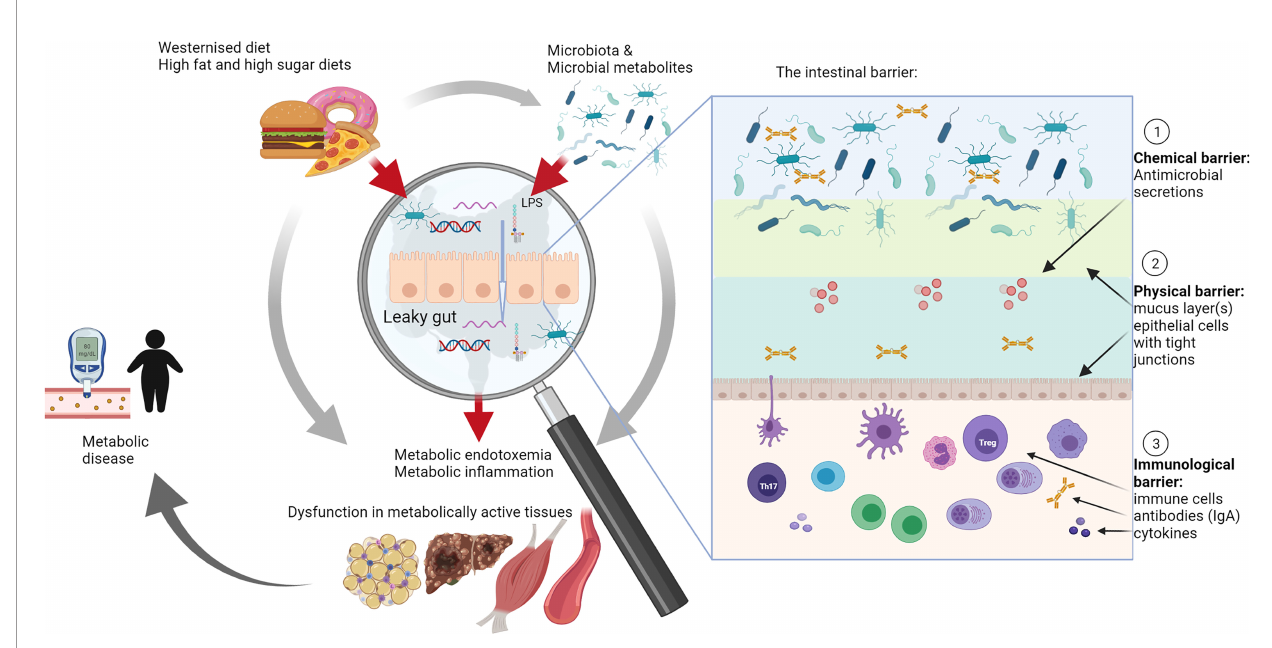
FIGURE 1 | The role of intestinal barrier dysfunction and leaky gut syndrome in metabolic disease. A high fat and/or westernized diet affects and/or changes microbiota composition. Microbiota composition was associated with metabolic diseases in a large number of studies that investigated these in conjunction with metabolic outcomes, such as increased or decreased body weight, changes in glucose metabolism and effects on metabolically active tissues such as adipose tissue, liver and muscles (grey arrows) (18, 23 – 28). However, increasingly research is focusing on the role of the leaky gut, particularly investigating the role of the intestinal barrier and its different layers, including chemical, physical and immunological barriers (see insert), as mediators of interactions with diet and microbiota in the development of metabolic diseases (red arrows). Studies in this area are relatively limited, but this review summarizes compelling evidence for a leading role of the gut in development of metabolic disease through modulation of this complex intestinal barrier. IgA, immunoglobulin A; LPS, lipopolysaccharide; Th17, T helper cells 17; Treg, regulatory T